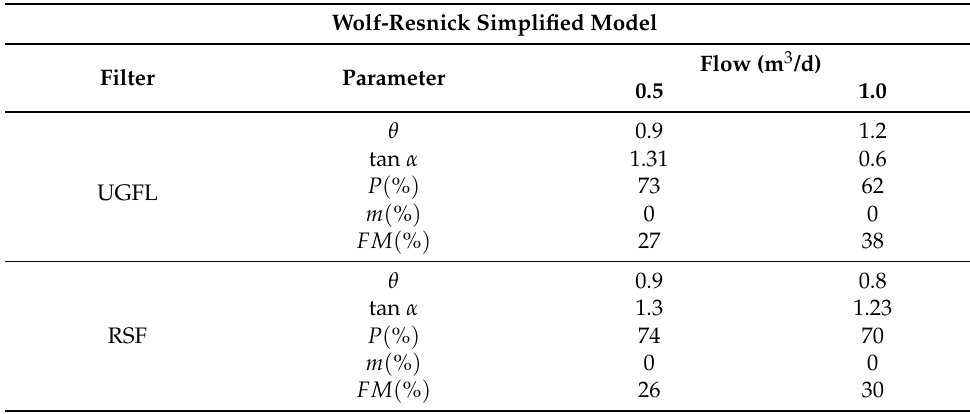
Figure 5. Variation of tracer concentration in RSF effluent–Flow 0.5 m 3 /d. Table 4. Results of the application of the simplified Wolf-Resnick